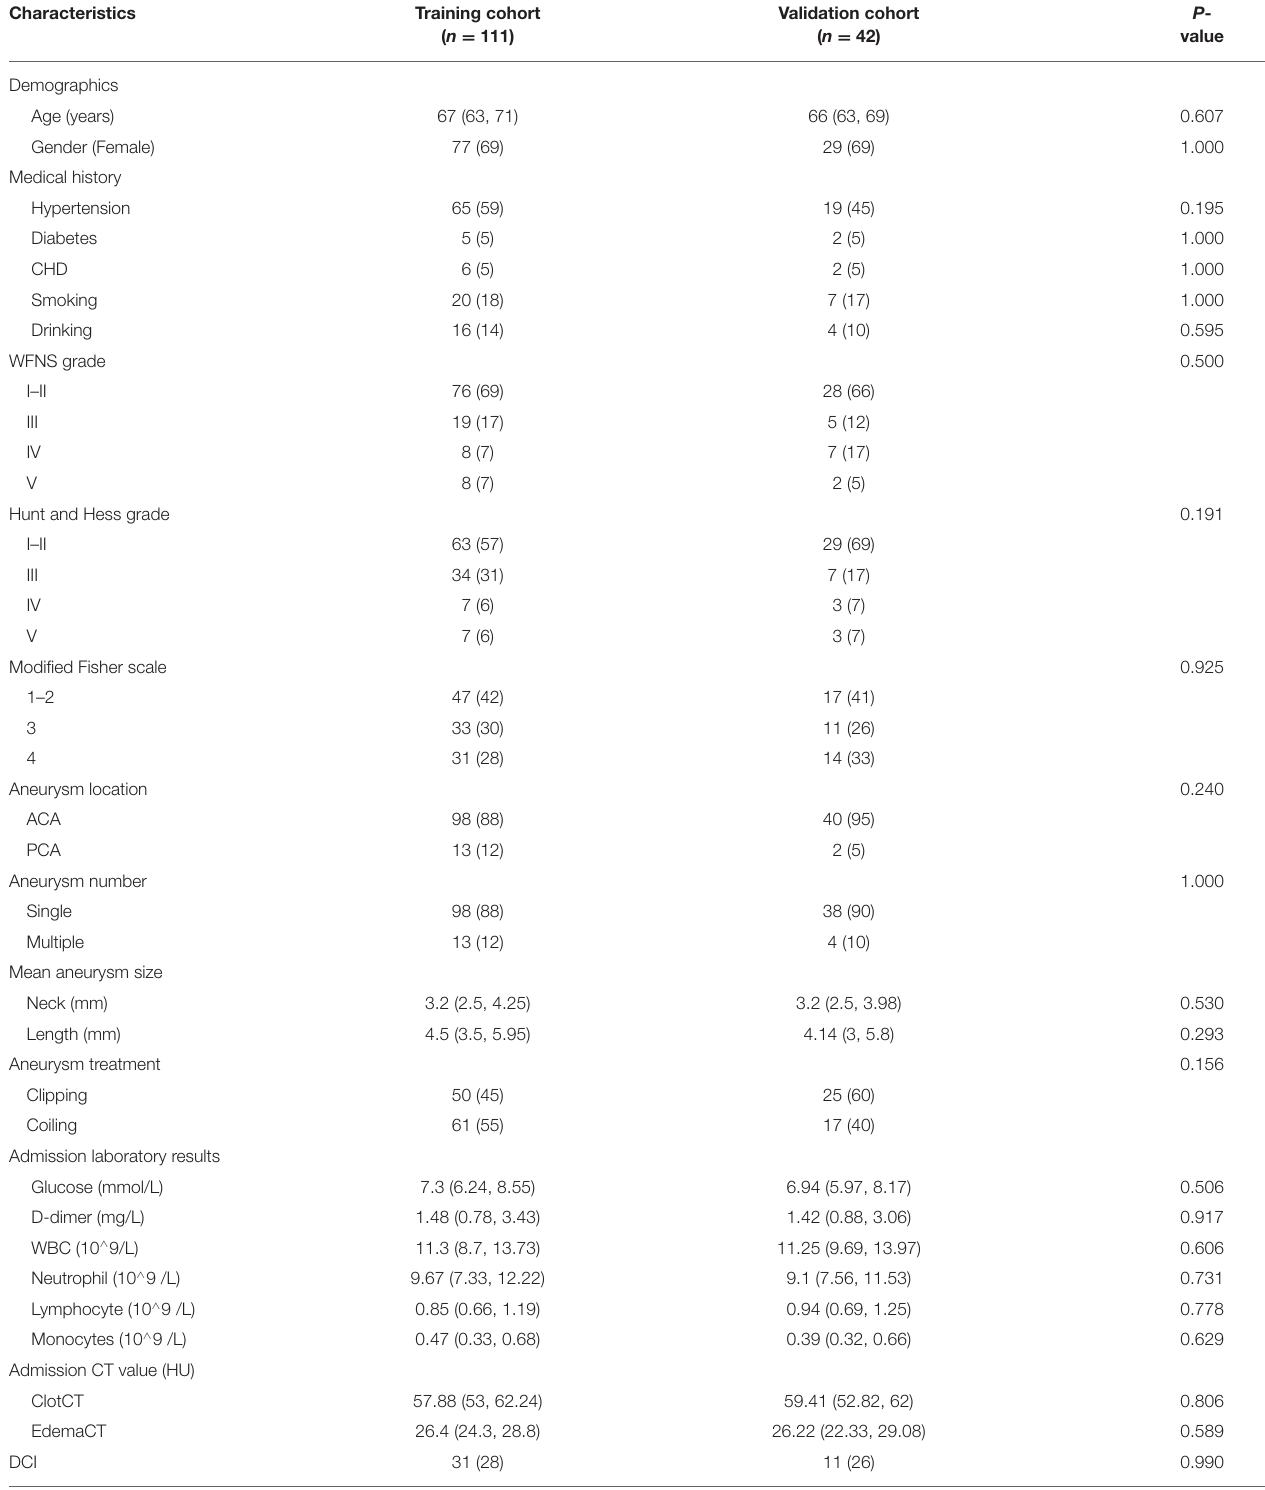
TABLE 1 | Baseline characteristics of the elderly patients in model training and validation cohorts.